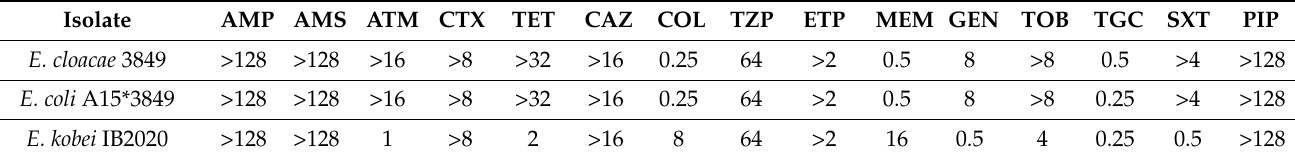
Table 1. Antibiotic susceptibility profiles of the E. cloacae 3849 (ENCL_3849) and its transconjugant E. coli A15*3849 and ENCB_IB2020 carrying bla VIM-1 and mcr